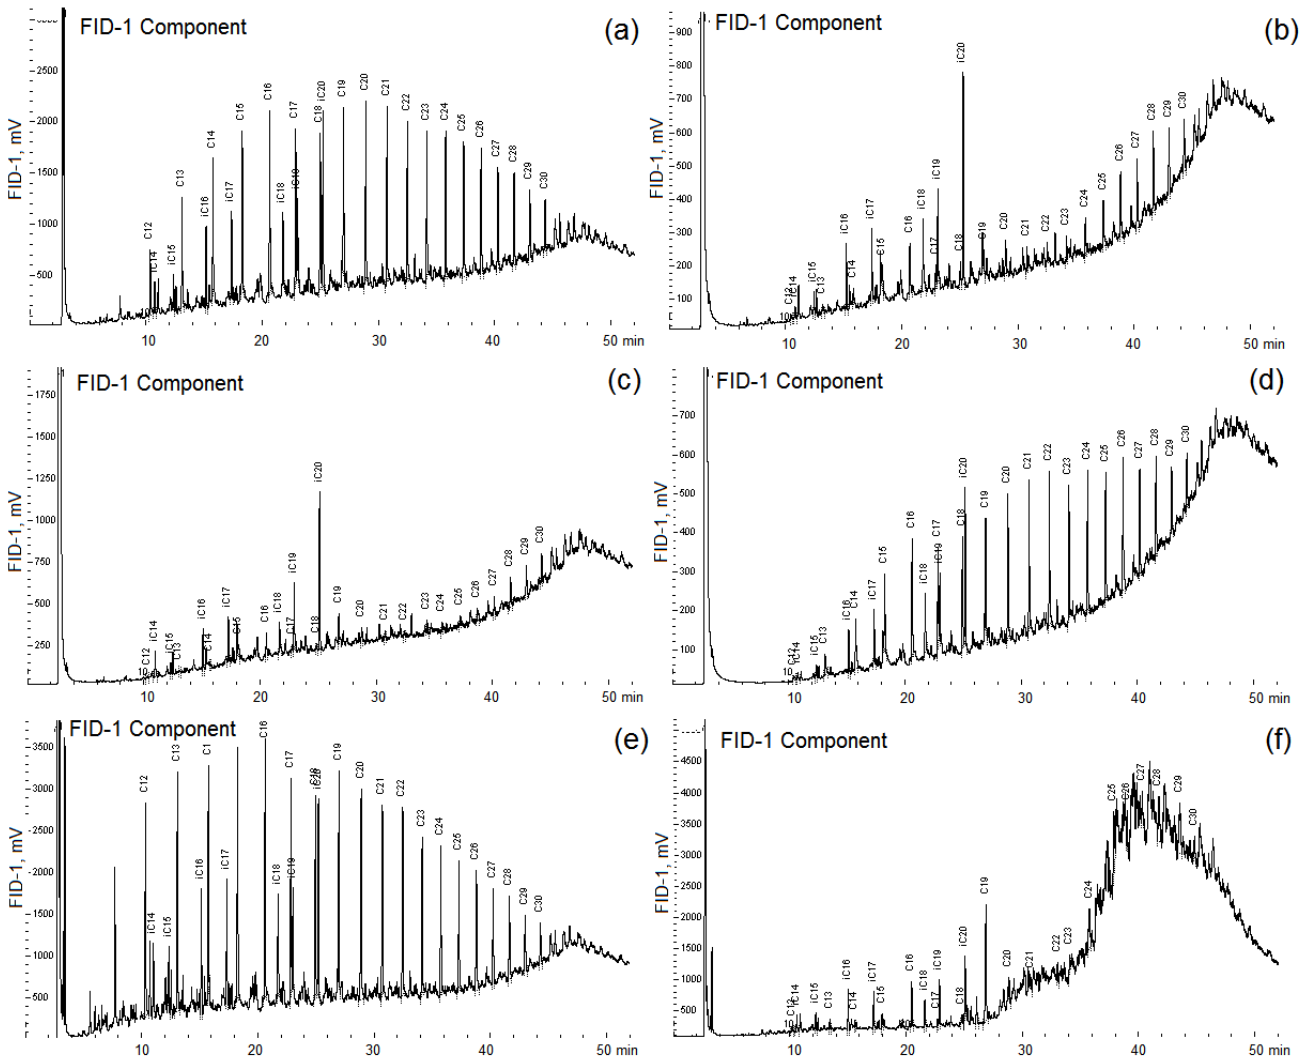
Figure 5. Chromatograms of n -alkanes of crude oil (control, ( a )) and of oil degraded by Pseudomonas brenneri M6-6 ( b ), Rhodococcus erythropolis M7-8 ( c ), Serratia myotis M7-5 ( d ), Pseudomonas kielensis M11-25 ( e ), and by Rhodococcus erythropolis M2-15 ( f ). Strains were incubated in a medium with 0.2% ( v/v ) crude oil for 30 days at 10 °C.